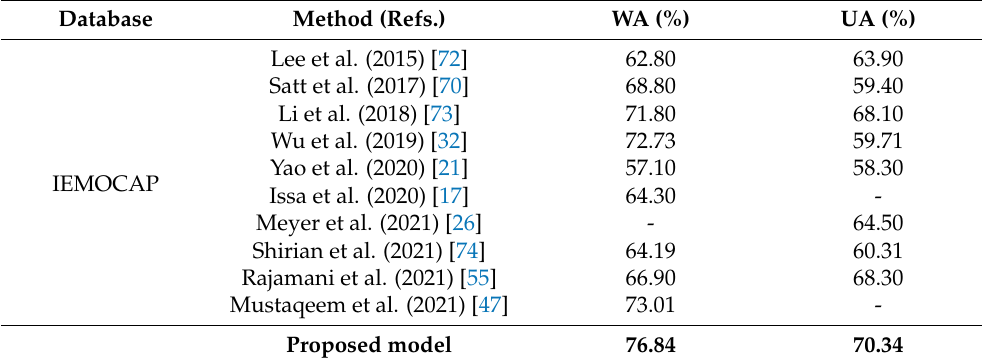
Table 6. Performance (%) comparison between our proposed method and state-of-the-art methods on the IEMOCAP dataset.